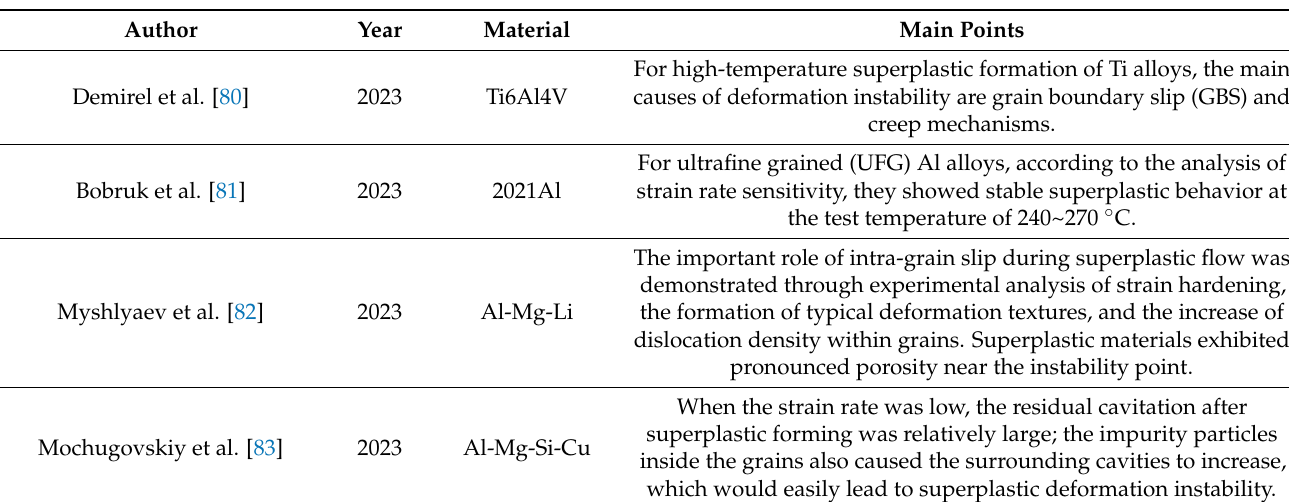
Table 2. A review of recent research on the superplastic deformation instability of alloy